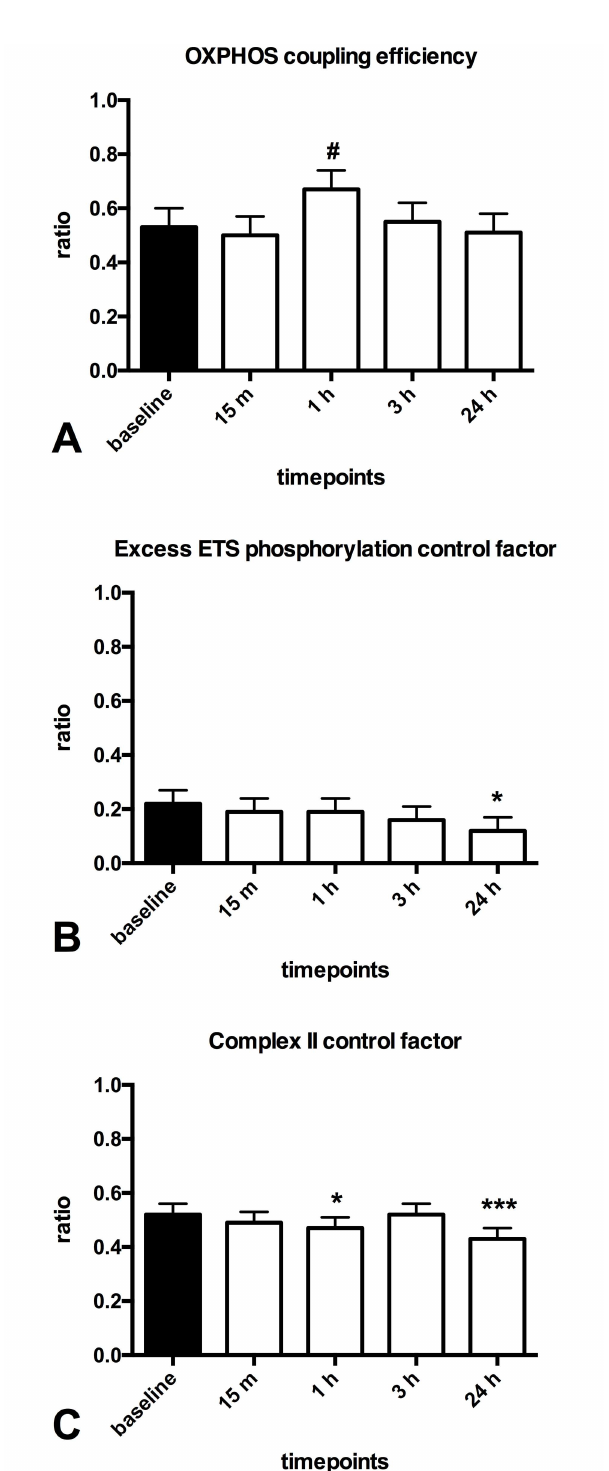
Fig 6. Effect of one session of calf raises upon mitochondrial function in healthy older adults. (A) : oxphos couplingefficiency (1 - (ETF+CI) L / (ETF+CI) P ) (B) : Excess ETS-phophorylationcapacity factor (1 - (CI+CII+ETF)P / (CI+CII+ETF) E ) (C) : complex II control factor (1 - (CI+ETF) P / (CI+CII+ETF)P)Black (baseline);white (post-exercise). Values are mean and standard error of the mean, n = 11. # trend to a significant difference (P < 0.1), * Significantly different from pre (P < 0.05), ** Significantly different from pre (P < 0.01), *** Significantly different from pre (P < 0.001)